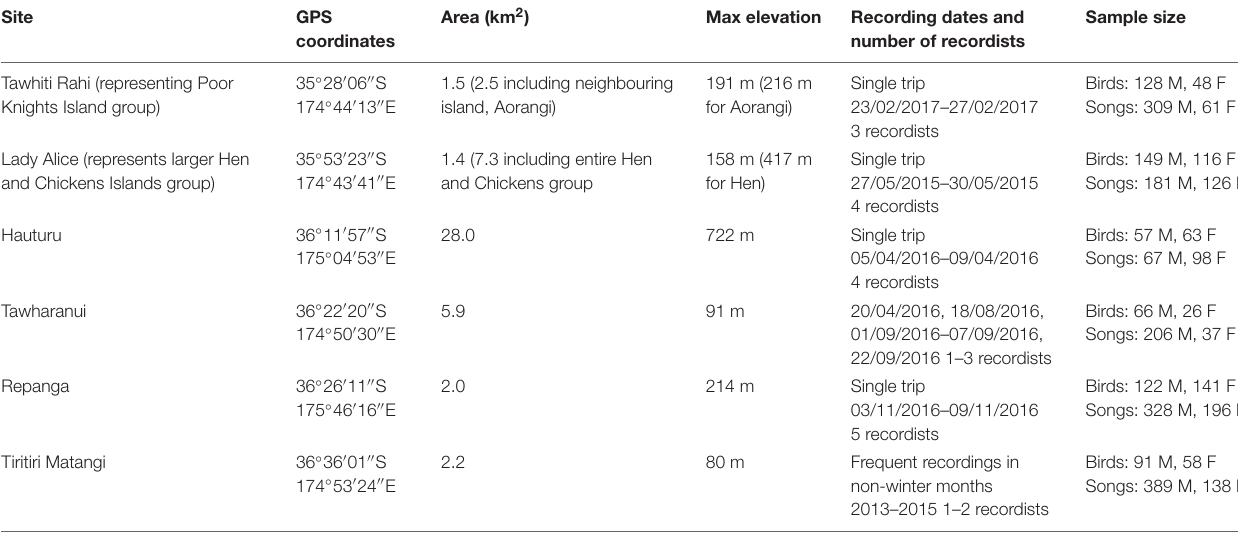
TABLE 1 | Geographic and sampling information for the six study sites.